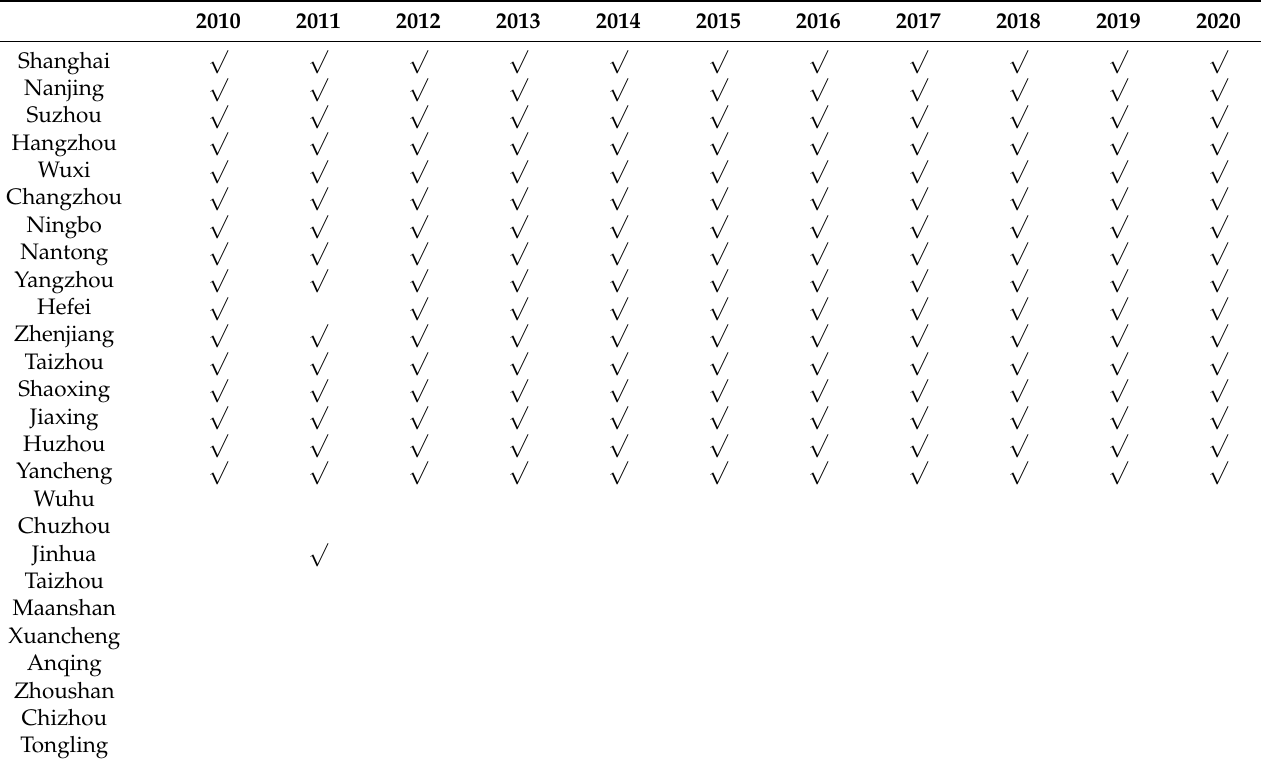
Table 5. Core-marginal analysis of the housing prices’ association network in the YRDUA from 2010 to